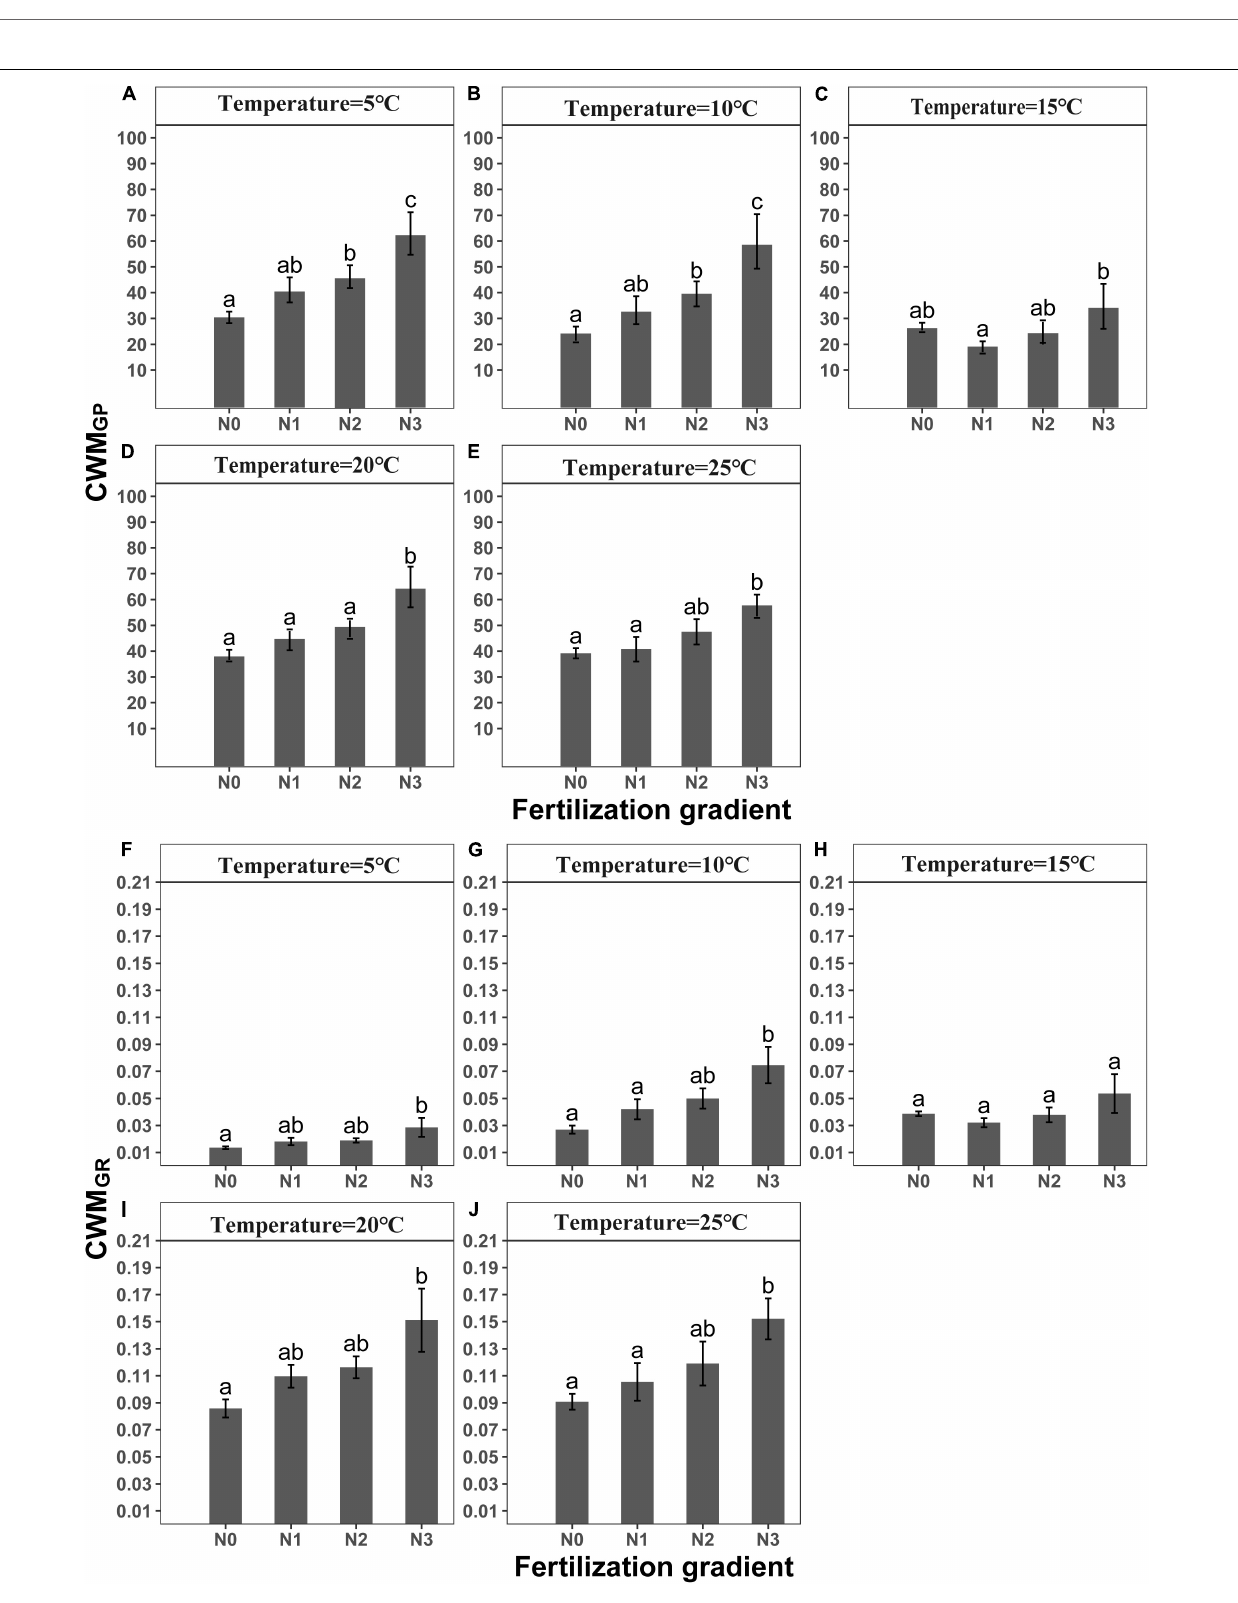
Frontiers in Plant Science |